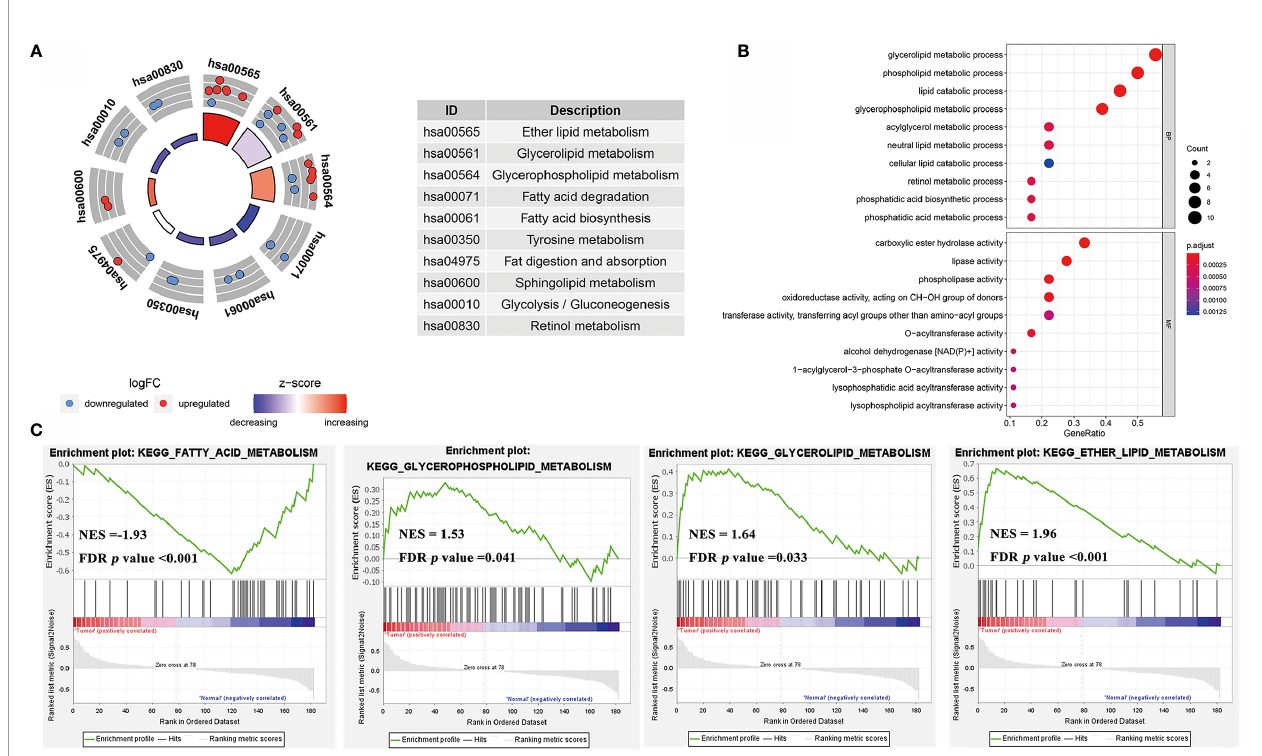
FIGURE 6 | (A) The circle diagrams of KEGG pathway enrichment. (B) The bubble diagrams of GO terms enrichment. (C) The gene set enrichment analysis (GSEA) curves of KEGG pathways of lipid metabolism in GC rather to normal